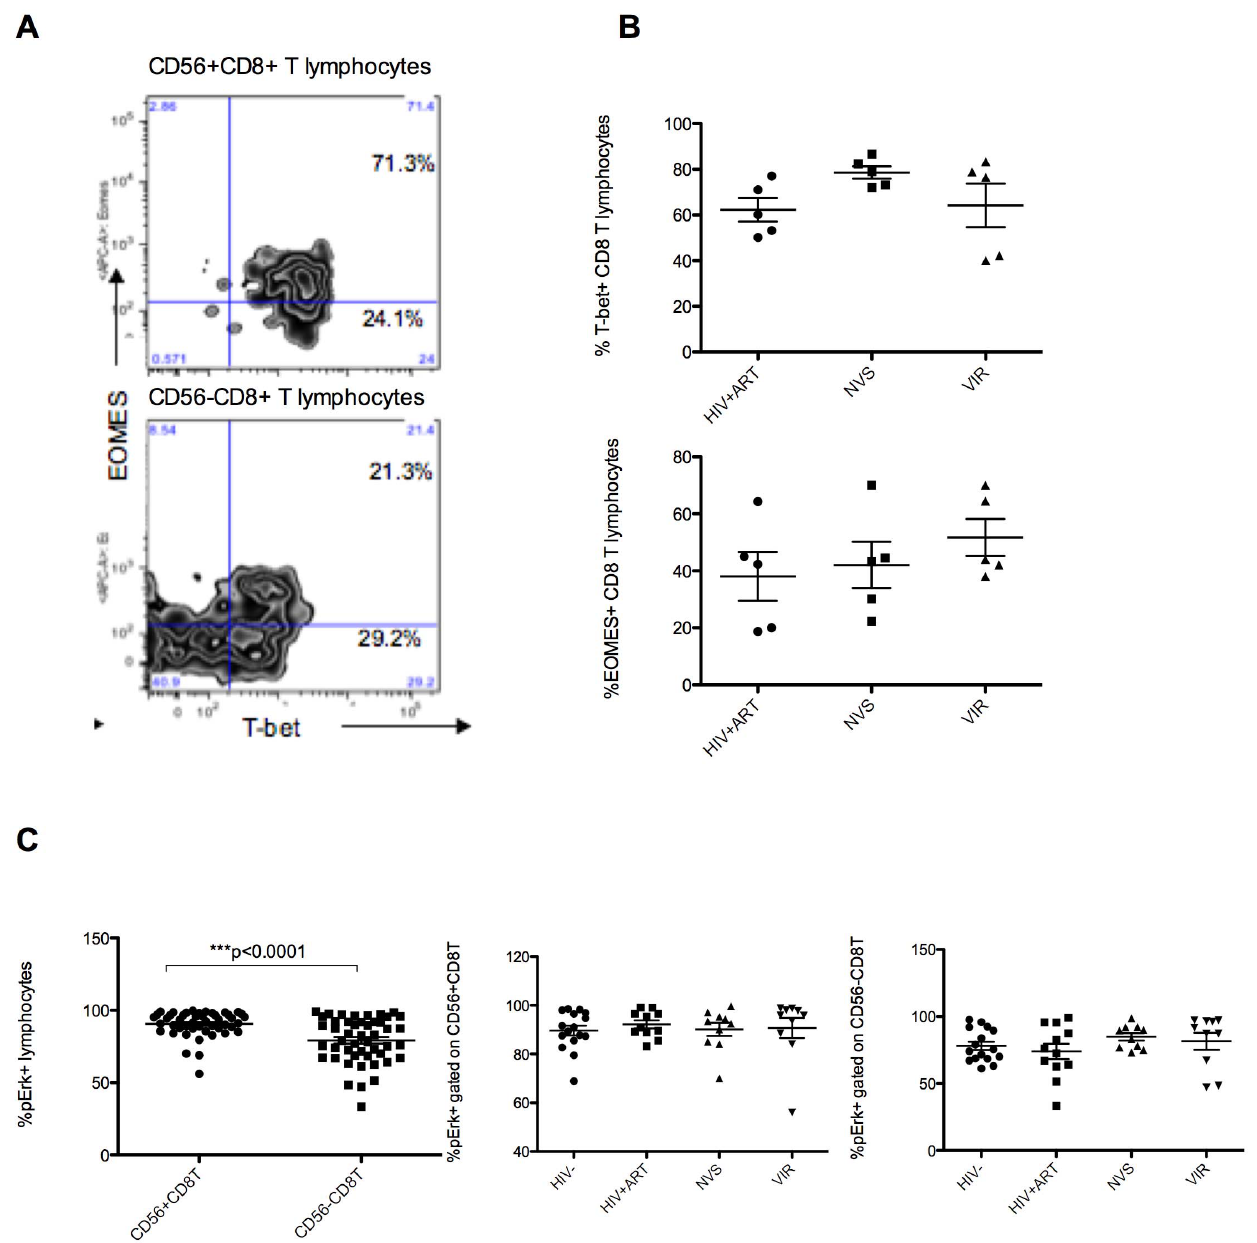
Figure 3. Transcription factors and MAPK signaling in CD56 subset. EOMES and T-bet control cytotoxic function of effector T cells. (A) Majority of CD56 + CD8 T cells expressed T-bet and/or EOMES and were double positive for these transcription factors, whereas a significant proportion of CD56- CD8 T cells were double negative for EOMES and T-bet. The representative plots show the trends presend in CD56 + or CD56- subsets from all patient groups irrespective of disease status (B) NVS group had highest frequency of T-bet expressing CD8 T cells whereas there was no significant difference in EOMES positive CD8 T cells among different cohorts of HIV infected patients. (C) Overall, the CD56 + fraction of CD8 T lymphocytes had higher levels of Erk phosphoryation upon PMA + inomycin stimulation compared with the CD56- CD8 T lymphocytes when samples from all groups were combined for analysis. CD56 + or CD56- CD8 T lymphocytes showed similar levels of Erk phosphorylation in all infected and control